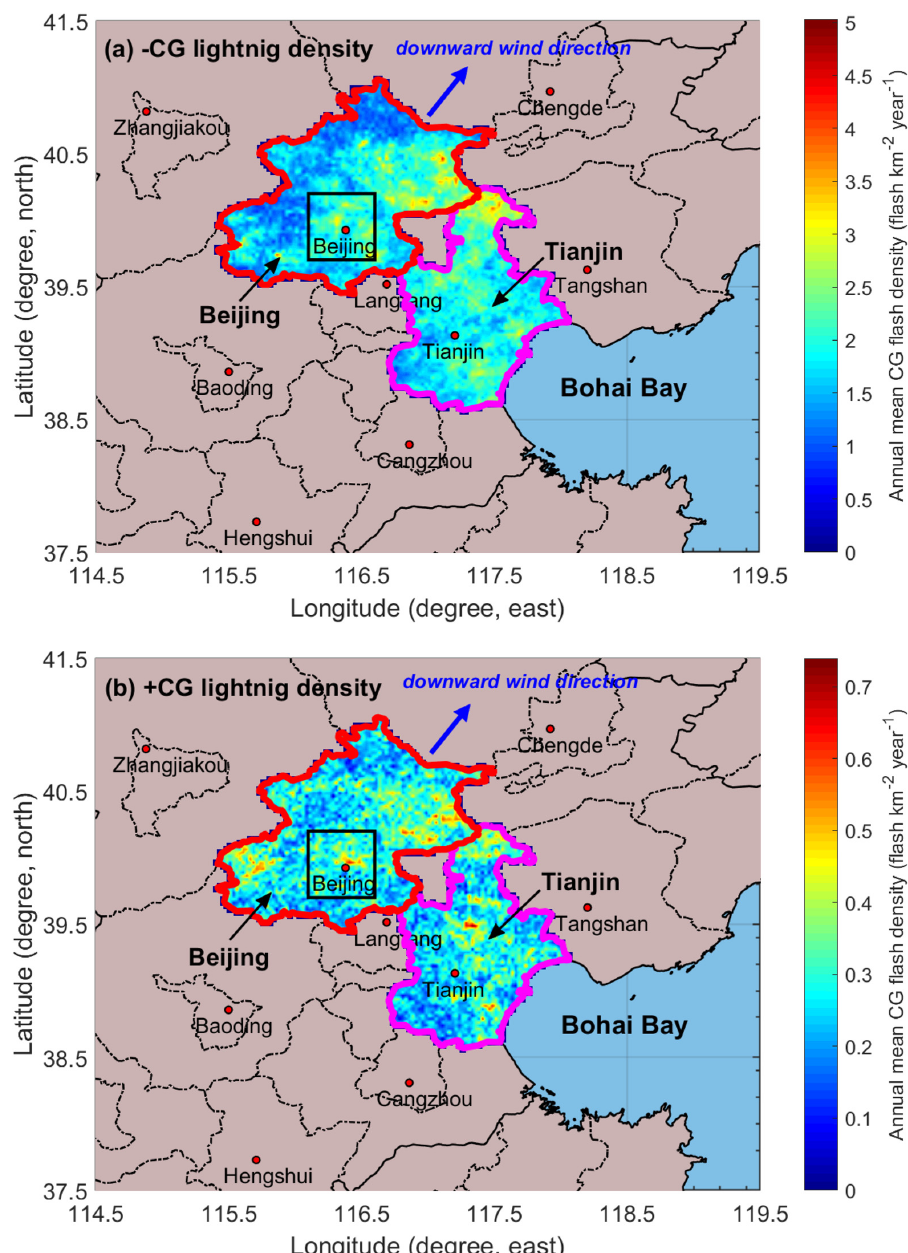
Figure 3. ( a , b ) Geographical distribution of the negative and positive CG lightning density. The black rectangle indicates the downtown of Beijing.